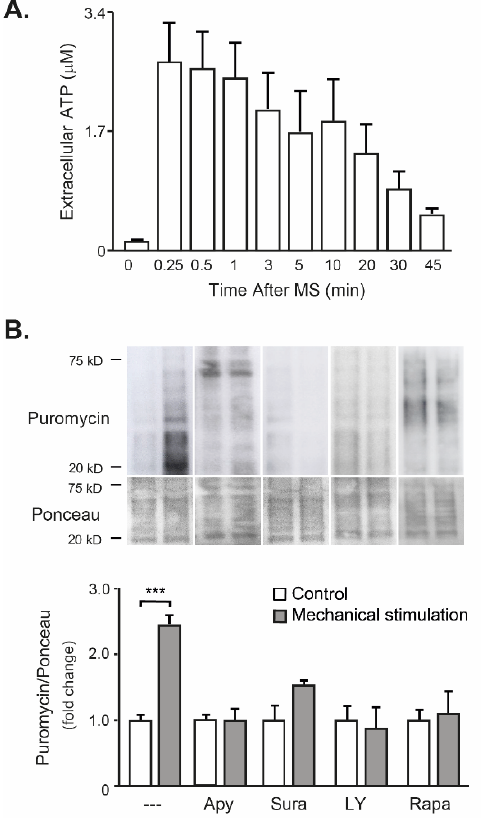
Figure 5. Extracellular ATP is the mediator released by the mechanical stimulation of osteoclasts that leads to protein synthesis in FDB muscle when they are co-cultured. The experimental model of Transwell ® chambers was used, as detailed in Figure 1. ( A ) Measuring of eATP in the lower chamber, after mechanical stimulation of osteoclasts cultured at the upper compartment. This experiment was performed without any muscle in the lower compartment. Extracellular ATP was measured in the cell media ( n = 3). ( B ) In an indirect co-culture system, with osteoclasts in the upper chamber and isolated FDB in the lower chamber, mechanical stimulation of osteoclasts leads to protein synthesis in FDB muscles. The latter was prevented by 30-min pre-incubation with 2 U/mL Apyrase (Apy, an ectonucleotidase that metabolizes extracellular ATP), 100 µM Suramin (Sura, P2Y/P2X receptor antagonist), 50 µM LY294002 (LY, PI3-kinase inhibitor) or 100 nM Rapamycin (Rapa, mTOR inhibitor). Osteoclasts were mechanically stimulated by pipetting 37% of the extracellular medium at the upper compartment, ten times. Protein synthesis was addressed at the FDB muscle by puromycin incorporation. Puromycin immunoblot (top) and its quantification (bottom) are shown. Mean ± SEM of 3–4 independent experiments is graphed. *** p < 0.001, Mann–Whitney test comparing control (undisturbed) with mechanical stimulation.